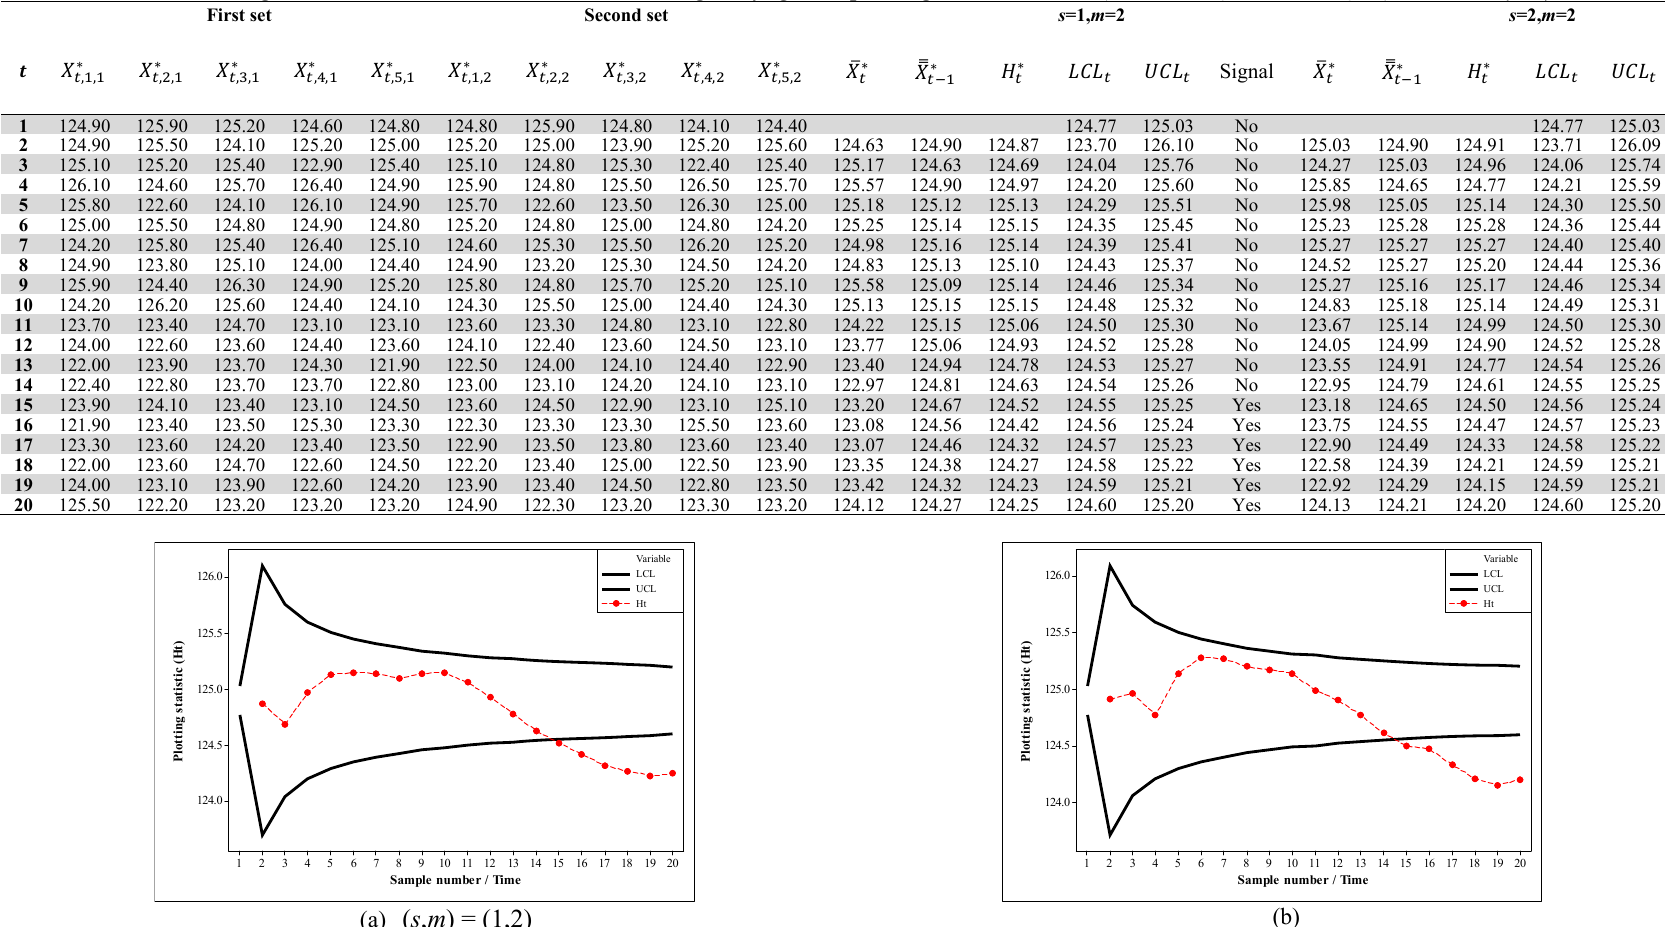
=1 and 𝑛 =2) when 𝑠 ∈ {1,2} and 𝑚 =2 (cid:3047)(cid:2879)(cid:2869) (cid:3047)